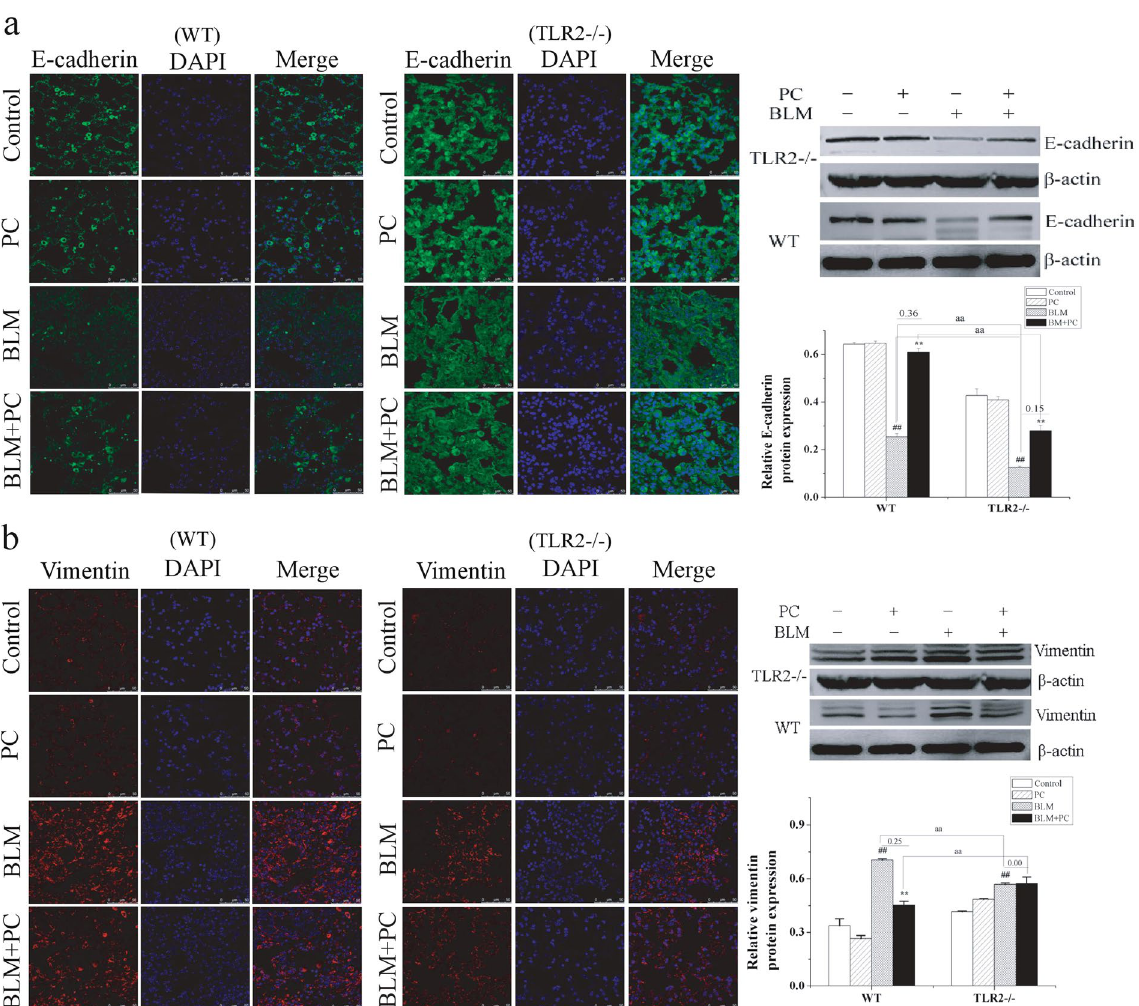
Figure 4. The effect of PC on E-cadherin and vimentin in BLM mice. Following treatment with 5 mg/kg BLM on first day, WT and TLR2 − / − mice received treatment for 28 days. Fluorescent immunocytochemistry for DAPI (blue) and ( a ) E-cadherin (green). ( b ) Vimentin (red). Images were visualised under a confocal microscope. Original magnification (400 × ). Western blot analysis and quantitative densitometry of E-cadherin protein and β -actin reference protein in representative lung tissue on day 28. Images are representative of the three independent studies. Data were expressed as mean ± SEM. ## p < 0.01 compared with the control group, ** p < 0.01 compared with the BLM group. aa p < 0.01 compared with WT